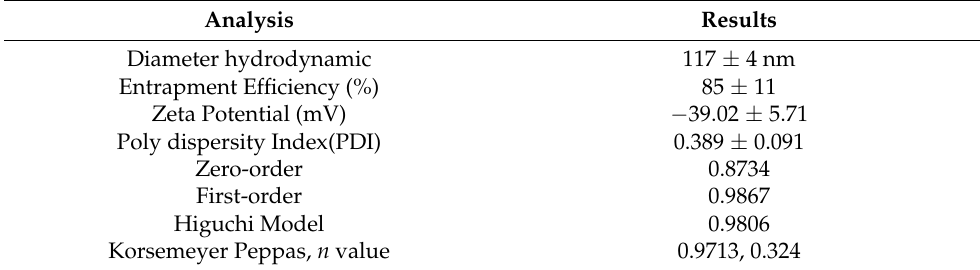
Table 1. WFA-NS physical and kinetic characteristics (Mean ± S.D, n =